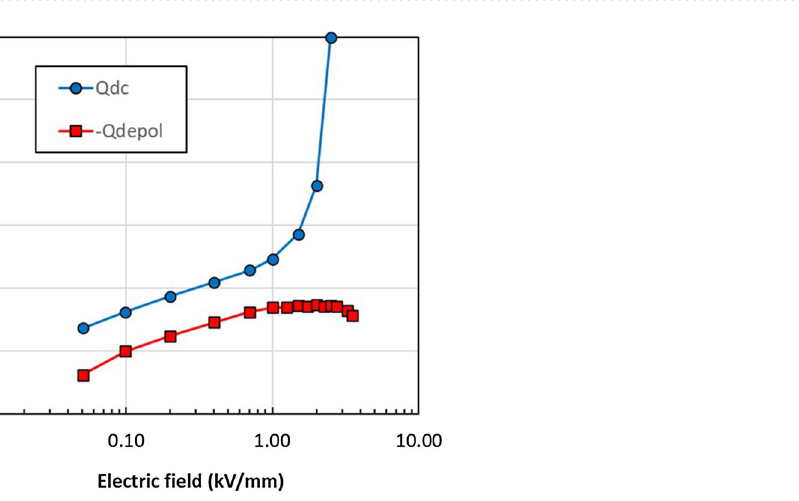
Figure 4. ( a ) Increase in conductivity with temperature, observed at E th < 1 kV mm −1 . ( b ) Decrease in conductivity with temperature, observed at E th > 1 kV mm −1 . Note the different Y scale between ( a ) and ( b ). The legend shows the electric field applied to perform each test, in kV mm −1 . Dashed lines in ( a ) are exponential fitting curves of the experimental data obtained using Eq. (2). For simplicity, only two fits of the tests performed at 0.20 and 0.40 kV mm −1 are shown; the other fit curves look very similar to the ones shown. All fitting results are in Table S2.